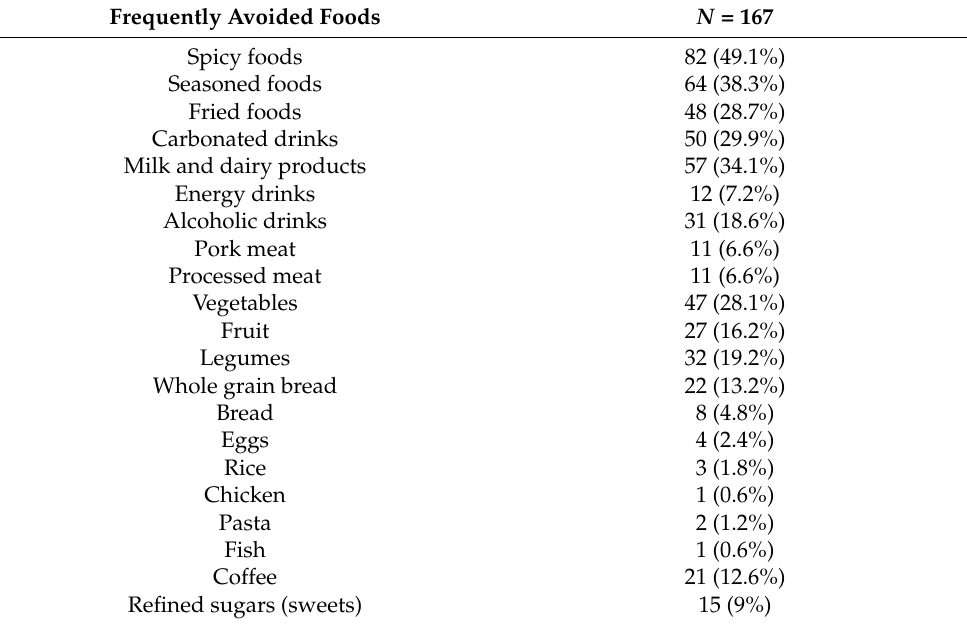
Table 6. Foods perceived as a symptoms’ trigger by patients with inflammatory bowel disease